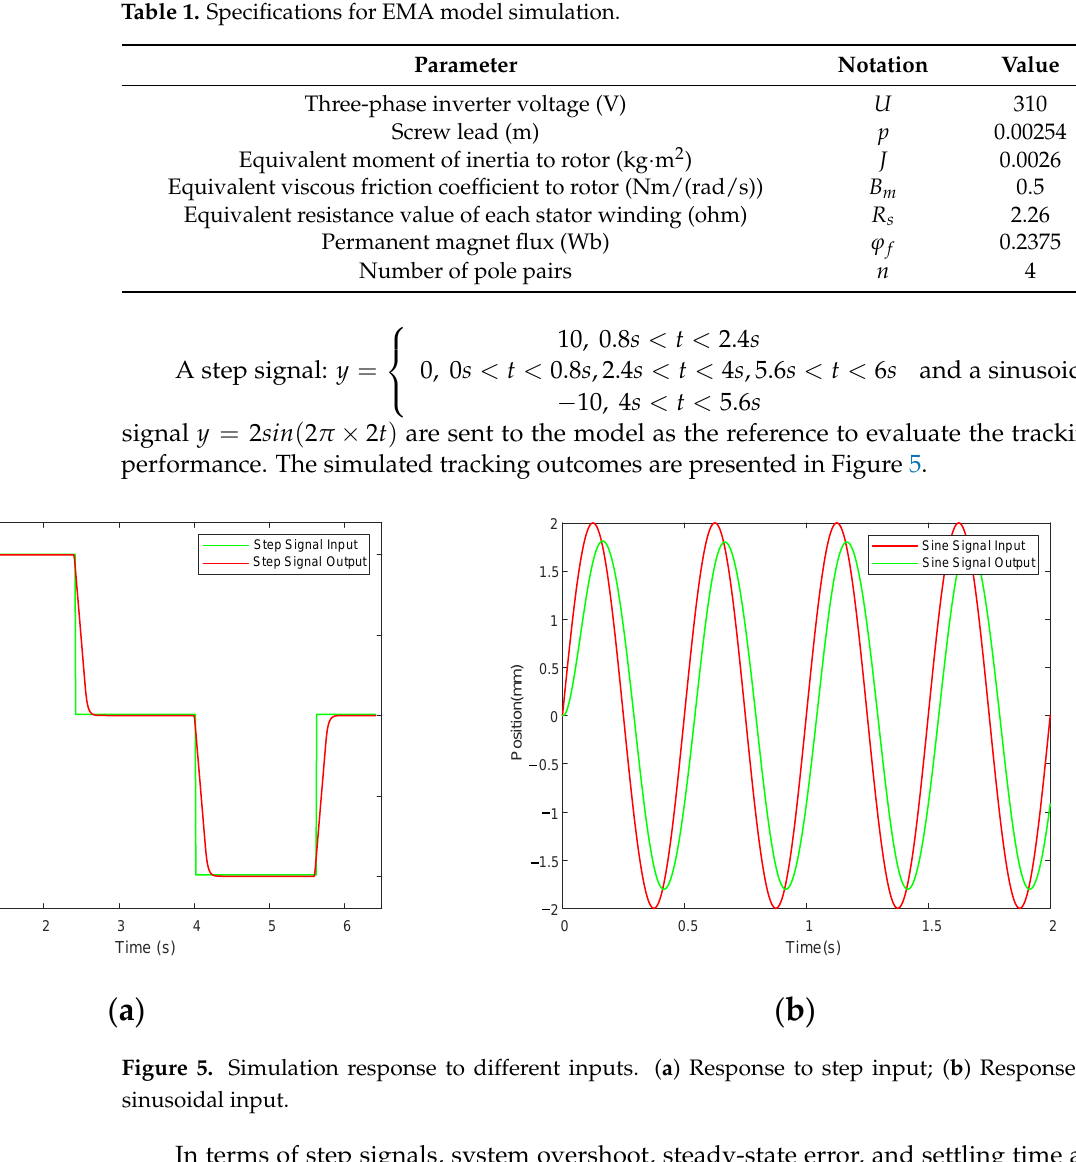
Table 1. Specifications for EMA model simulation.